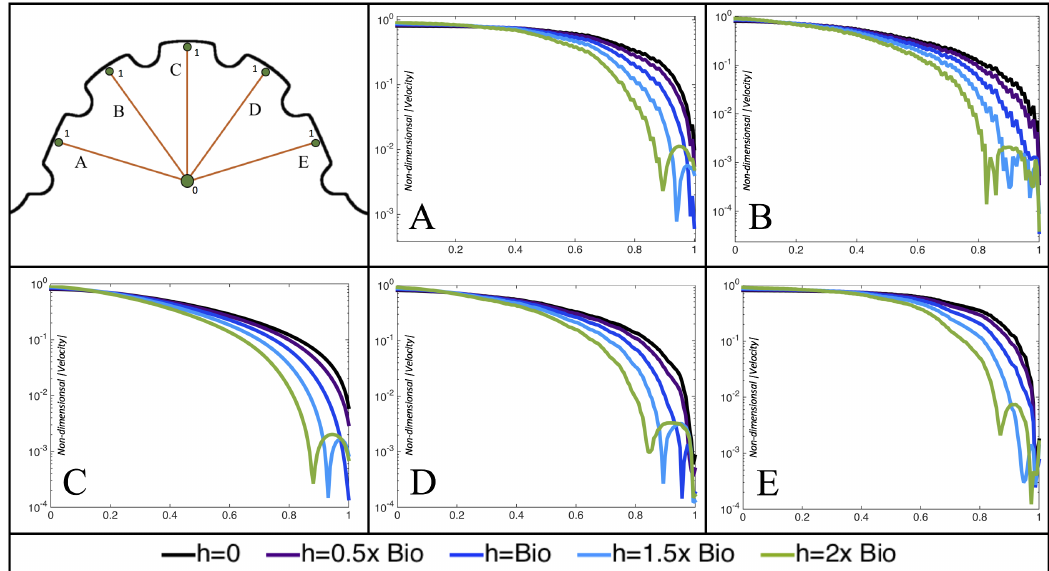
Figure 17. Measurements of the non-dimensional magnitude of velocity are provided for the Re = 1 case quantified along a line from the intracardial center (labeled “0”) and extending to the ventricular lining (labeled “1”) for various intertrabecular regions and trabeculae heights. The velocity magnitude strictly decreases from the center until around the neighboring trabeculae heights. The velocity magnitude then increases towards the center of the intratrabecular region, in some cases an order of magnitude, before dropping towards zero at the ventricle